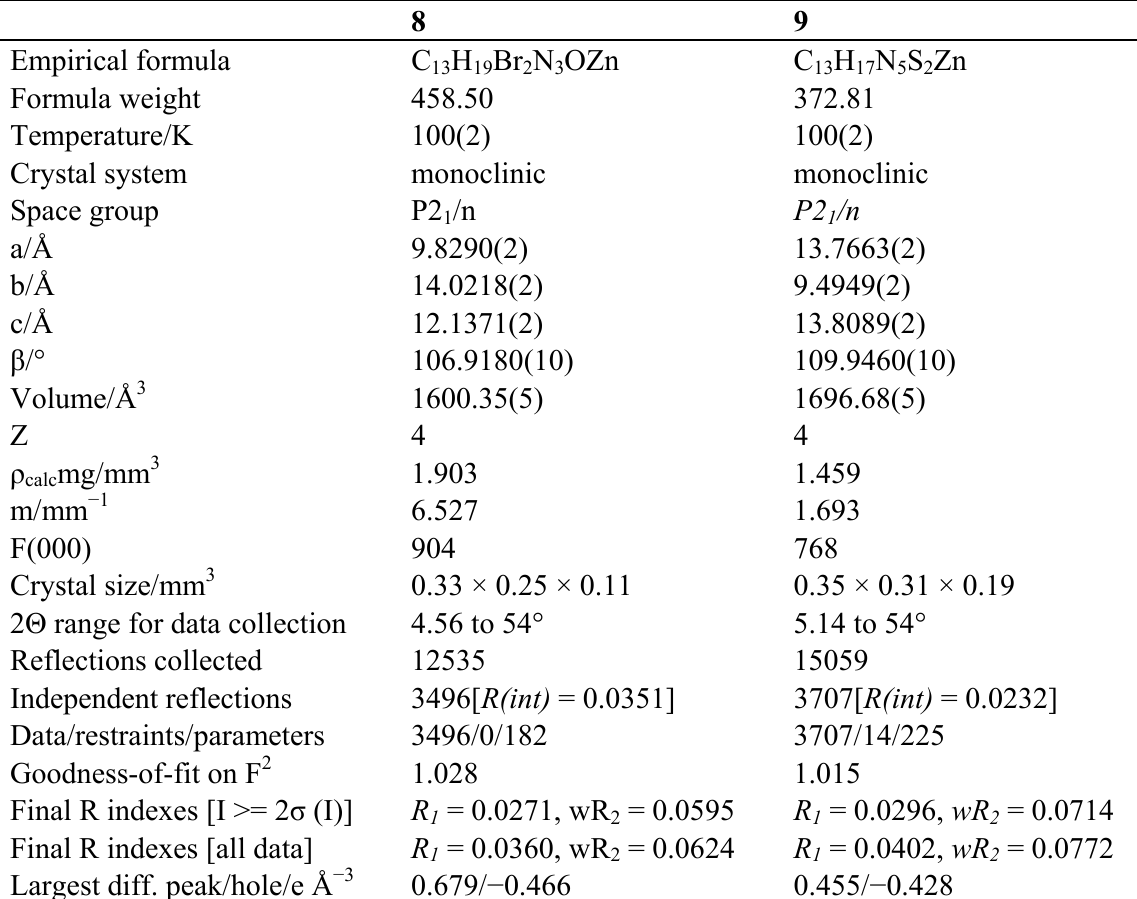
Table 2. Crystal data for compounds 8 and 9